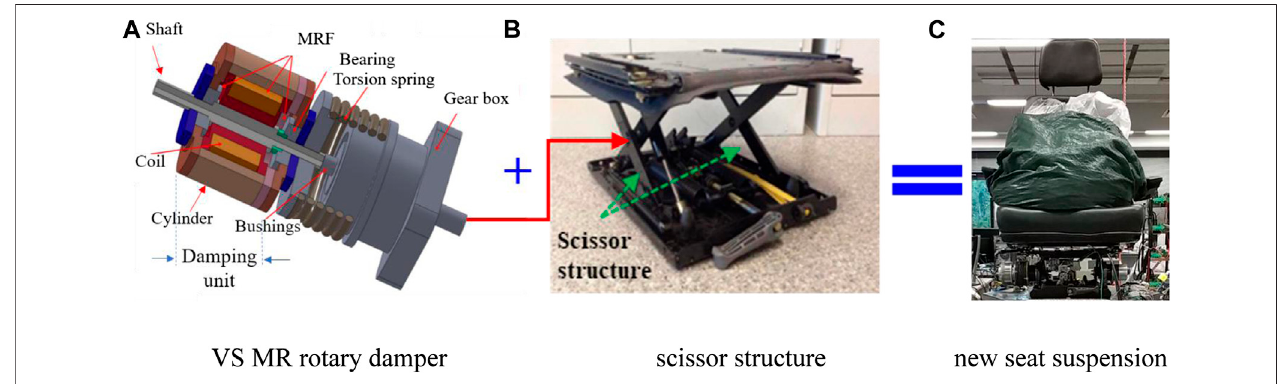
FIGURE 1 | The structure and prototype of the VS MR suspension